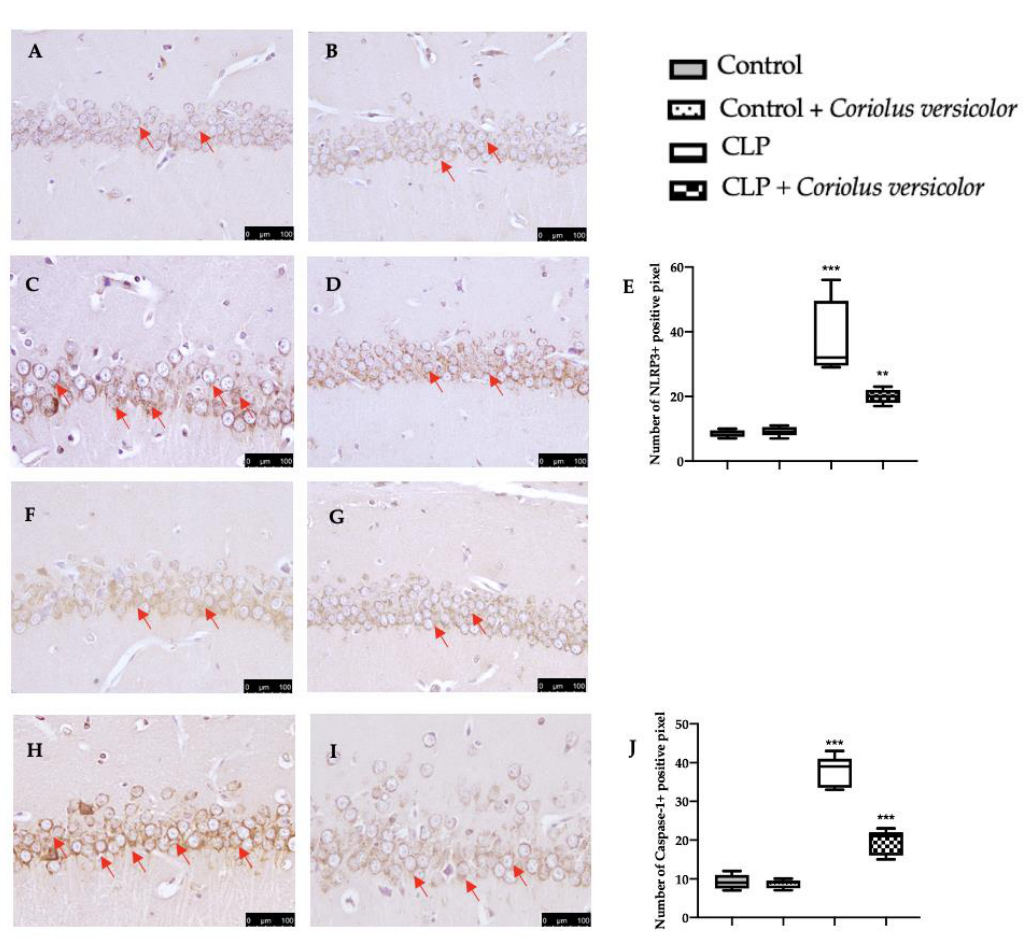
Figure 9. Coriolus versicolor reduced NLR family pyrin domain containing 3 (NLRP3) and Caspase-1 expression induced by CLP 28 days after surgery. Immunohistochemical analysis of NLRP3: Con- trol ( A ), Control + Coriolus versicolor ( B ), CLP ( C ), CLP + Coriolus versicolor ( D ), graphical quantifica- tion of NLRP3 expression (E), immunohistochemical analysis of Caspase-1: Control ( F ), Control + Coriolus versicolor ( G ), CLP ( H ), CLP + Coriolus versicolor ( I ), graphical quantification of Caspase-1 expression ( J ). ## p < 0.01 vs. CLP, ** p < 0.01 vs. Control, *** p < 0.001 vs. control, ### p < 0.001 vs. CLP.